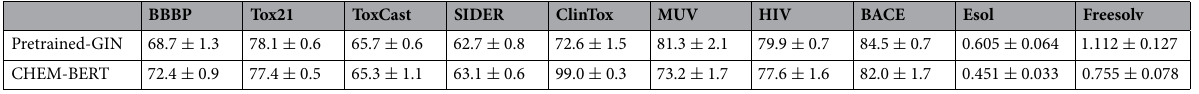
Table 4. Comparison with a pre-training strategy used in GNN. ROC–AUC (%) on classification tasks and RMSE on regression tasks.